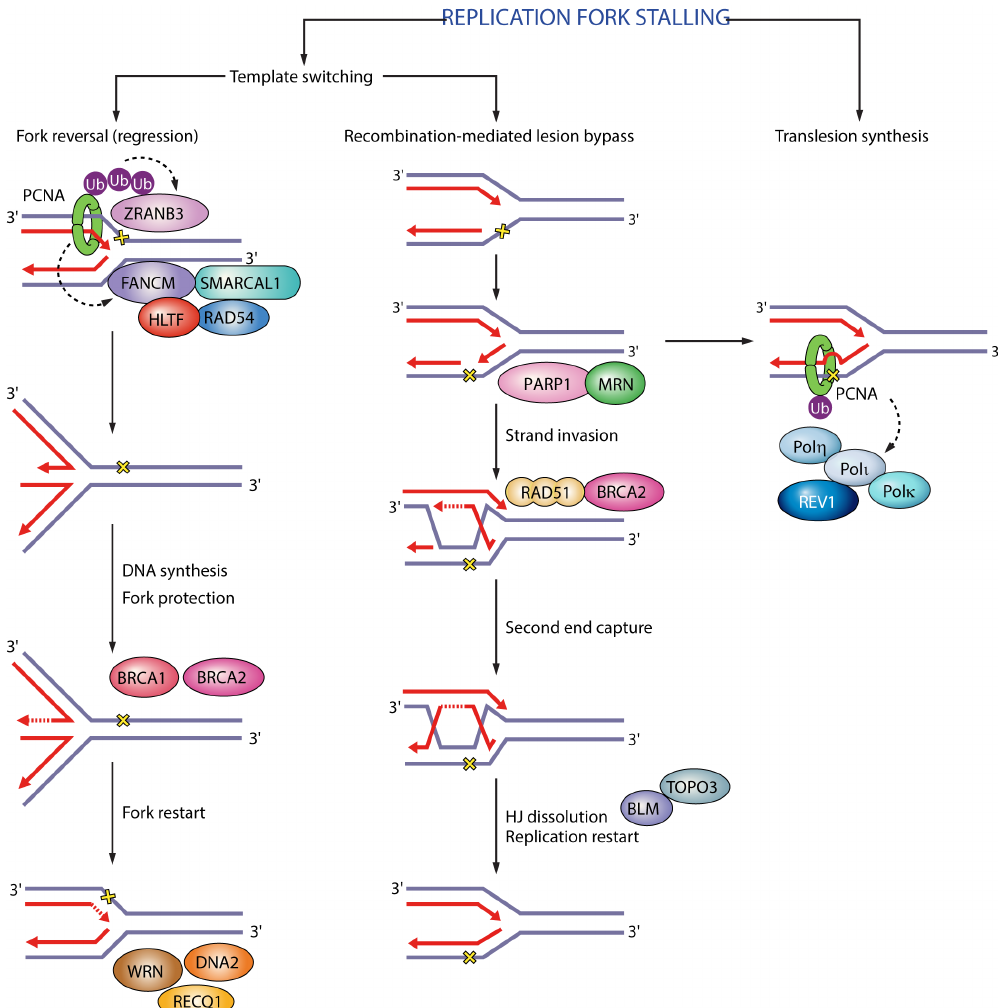
( B ) Interaction interface between PCNA and PIP-box shown for one PCNA monomer bound by one p21 PIP-box peptide. IDCL (pink), the central loop region (blue) and the C-terminal region (yellow) of PCNA anchor the PIP-box peptide through hydrophobic and electrostatic interactions. The sequence of the p21 PIP-box peptide is shown with the four critical residues indicated in bold. ( C,D ) Electron density distribution of PCNA from ( A , B ). The color-coded electrostatic surface potential of PCNA was drawn using the Adaptive Poisson-Boltzmann Solver package. The electrostatic potential ranges from 5 (red) to +5 (blue) kT/e. The images were generated using PyMOL [32]. − Genes 2018 , 9 , 416